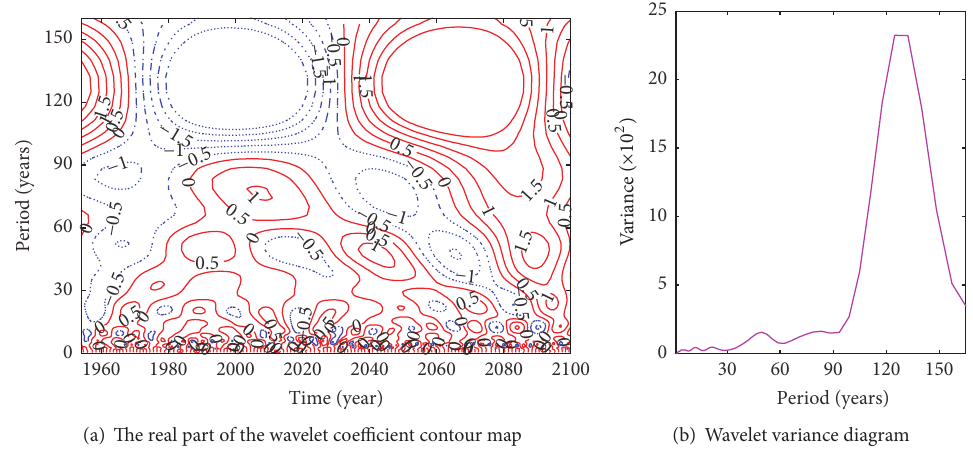
(b) Wavelet variance diagram